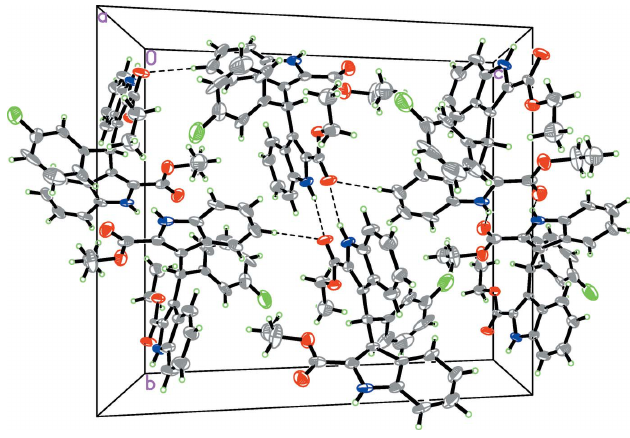
Figure 2 A packing diagram of the title compound. Hydrogen bonds are shown as dashed lines.